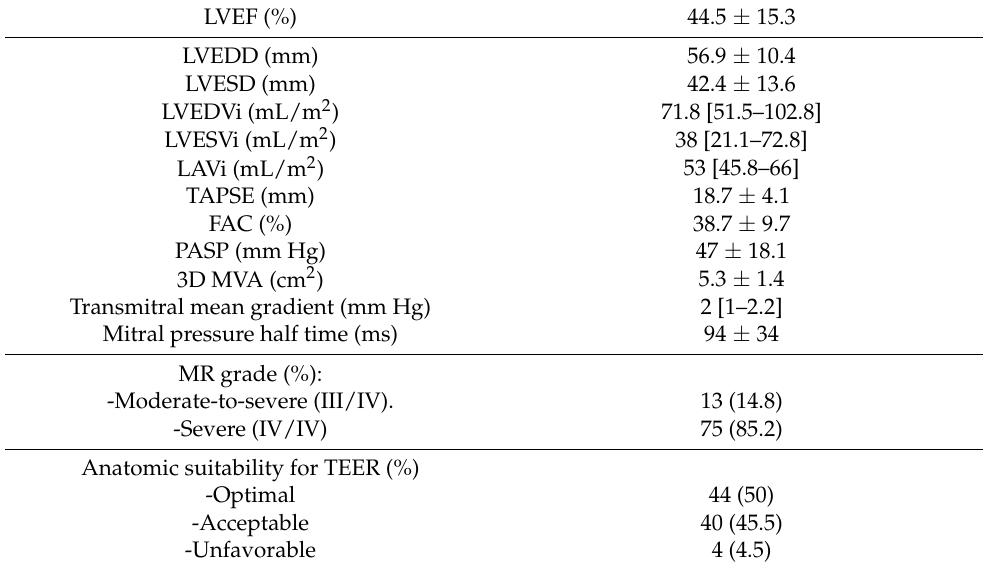
Table 2. Baseline echocardiographic